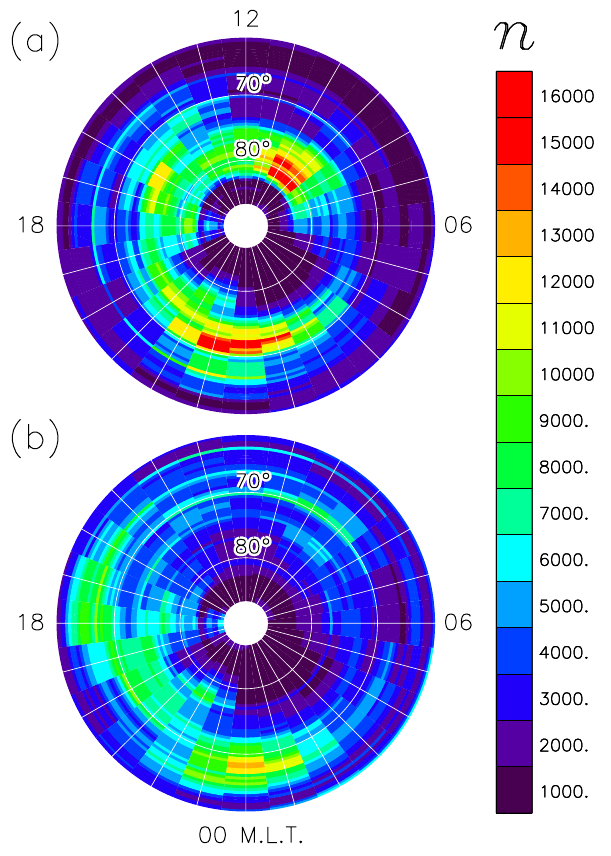
Fig. 3. Mass plots of the velocity fluctuations δ v los observed at 8 representative F-region group delays (675–2250km) on Tasmania beam 4 during 10:00 to 18:00UT on 17 December 2005. From top to bottom the fluctuations are shown at the 6 representative temporal scales τ =1, 8, 64, 2048, 4096, and 8192s (2.3h). Figure 4 show the Probability Density Functions (PDFs) of the velocity fluctuations calculated for each octave of tempo- ral scale between τ =1 s and 1 day. These PDFs were calcu- lated using the entire set of filtered Tasmania beam 4 fluc- tuations (2 915 381 samples at τ =1 s). As for hydrodynamic turbulence, the PDFs had more small fluctuations at small τ , and more large fluctuations at large τ . The PDFs were nearly indistinguishable for τ =1 to 8 s. However, the main feature of the PDFs was their strong leptokurtic form with weak con- vergence towards a Gaussian shape at the largest scales. The smooth black curves represent Gaussian functions with the same standard deviation as the measured PDFs at τ =1, 64 and 86 400 s. A Gaussian function is fatter than the equiv- alent leptokurtic function at small δ v los ; the standard devia- tion of the latter is strongly influenced by its heavy tail. The leptokurtic PDFs are consistent with the exceptionally bursty time series data, Fig.